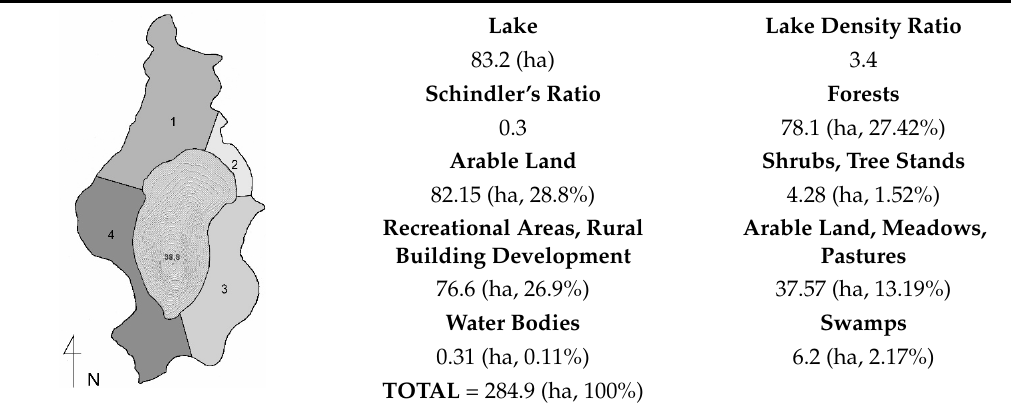
Table 2. The surface area and land use structure in the catchment of Lake Piaseczno in 2010 (adapted from [38]), and its division into sectors: 1, peatbog–forest–recreational (PFR); 2, recreational (R); 3, recreational–agricultural (RA); 4, forest–recreational (FR).